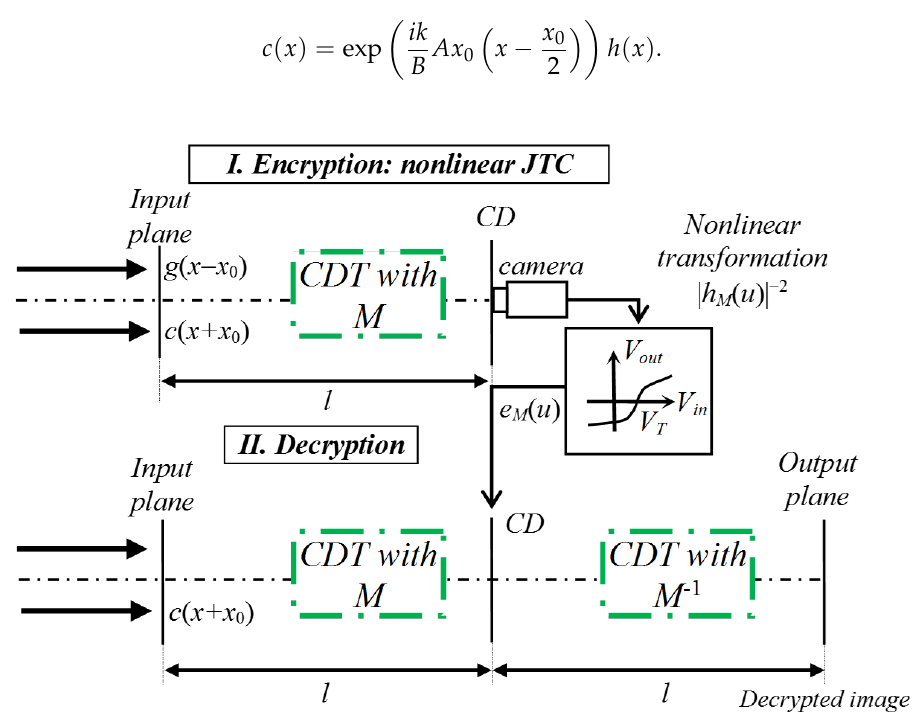
Figure 1. Schematic representation of the optical setup. The part I is the encryption system based on a nonlinear joint transform correlator (JTC) architecture in the Collins diffraction domain (CDD) and the part II is the decryption system composed by an two successive Collins diffraction transforms